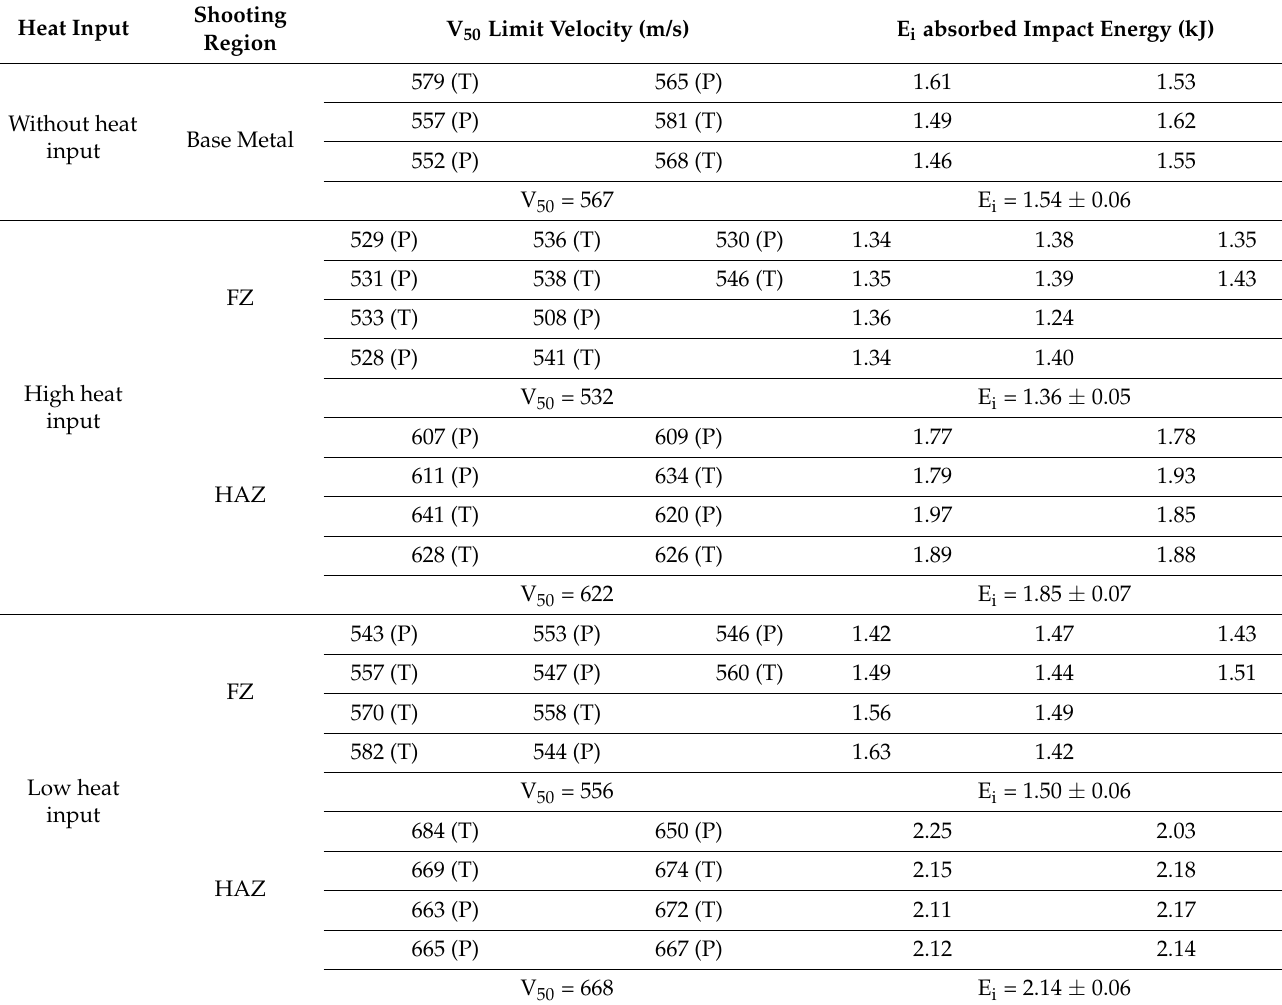
Table 5. Ballistic results for the investigated HHA weldment regions. (P = partial penetration; T = through perforation). Heat Input